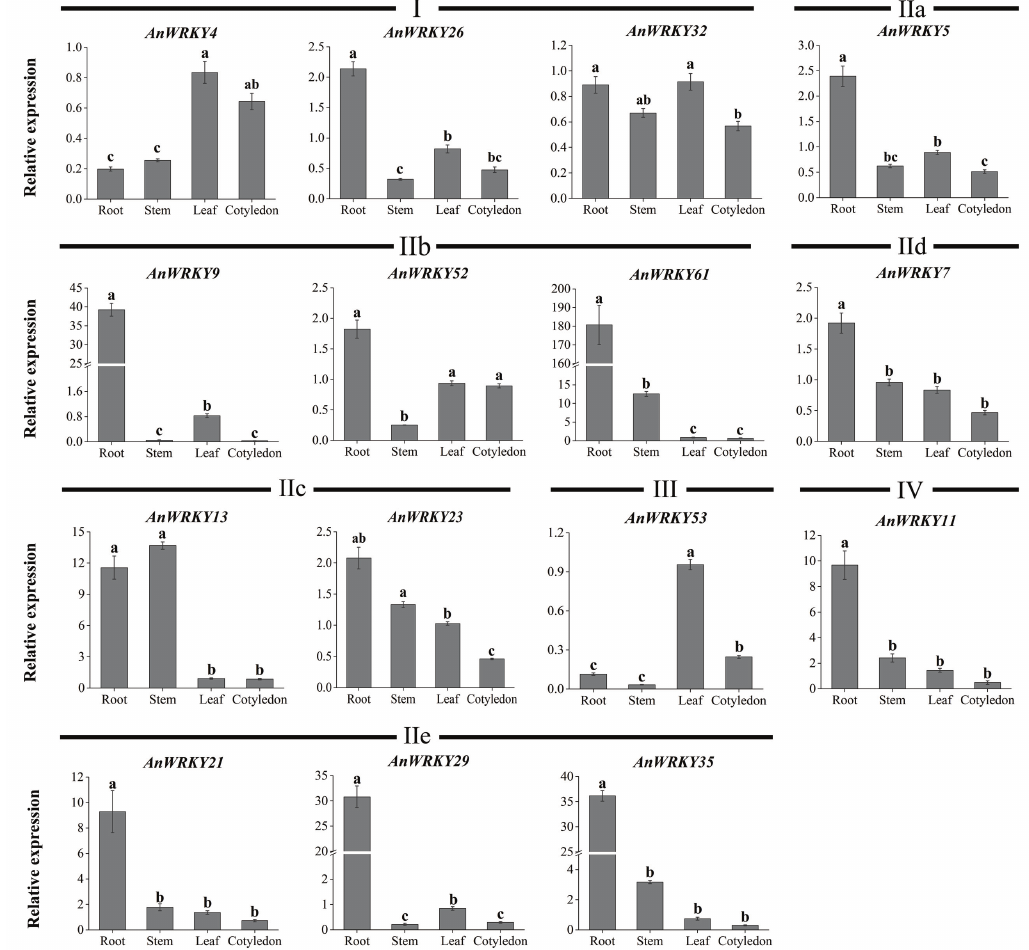
Figure 3. Expression analysis of 15 AnWRKY genes in roots, stems, leaves, and cotyledons. AnACTIN2 was used as an internal control. The mean and standard error (SE) were derived from three biological and three technical replicates. The di ff erent groups and subgroups are indicated above the graphs. Di ff erent letters indicate significant di ff erences at p < 0.05, Student’s t